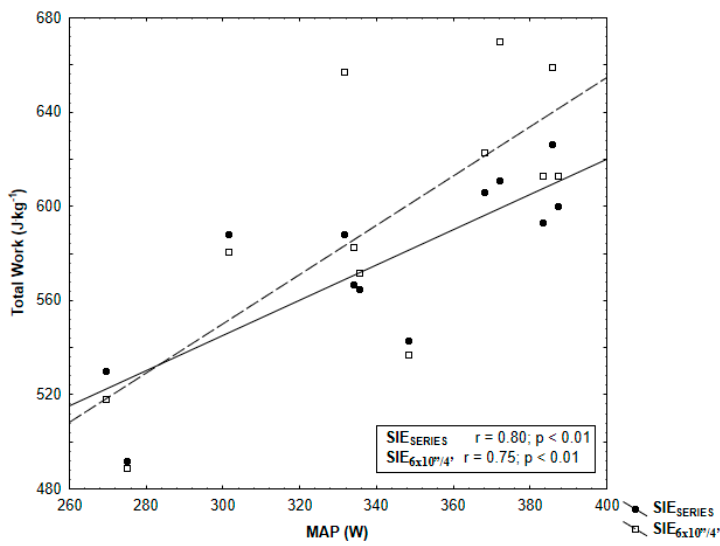
Figure 5. Pearson’s correlation of total work SIE SERIES and SIE 6 × 10” / 4’ with maximal aerobic power (MAP) determined in incremental exercise test.